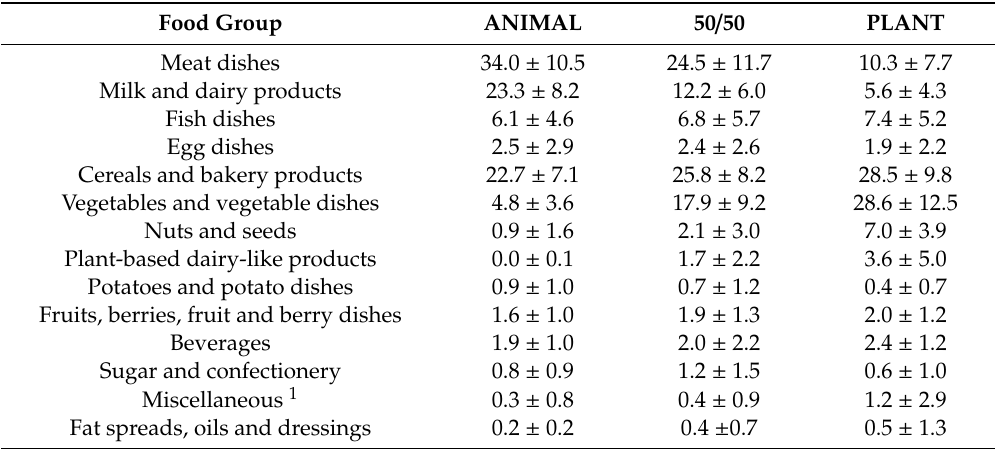
Table 4. Sources of protein in the intervention diets presented as average proportions (% ± SD) based on 4-day food record